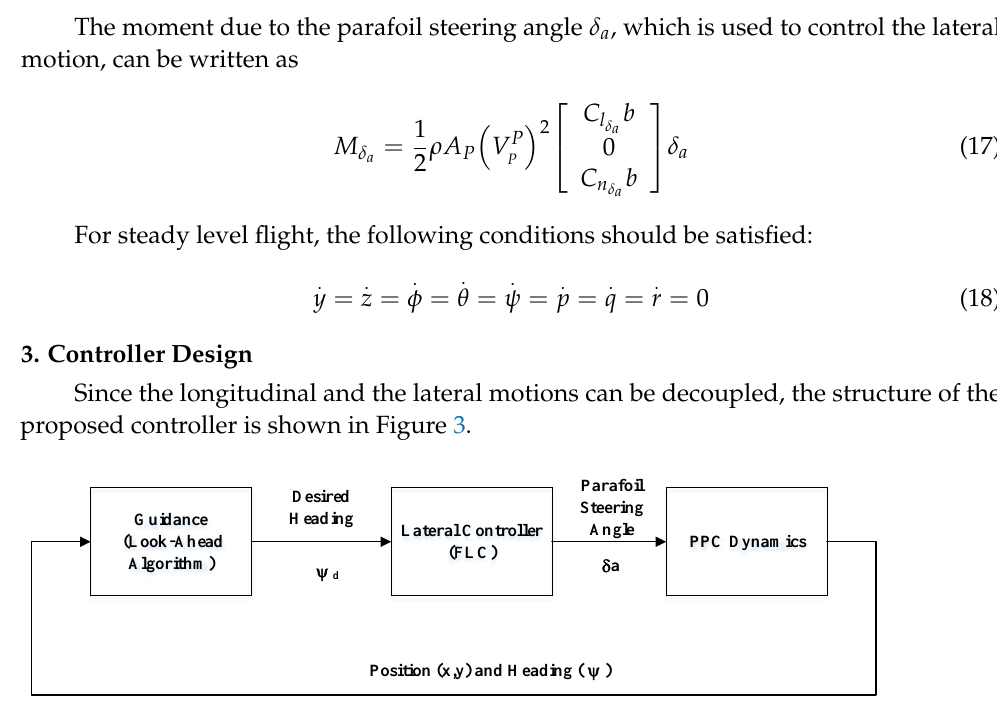
Figure 3. Guidance and control loop.